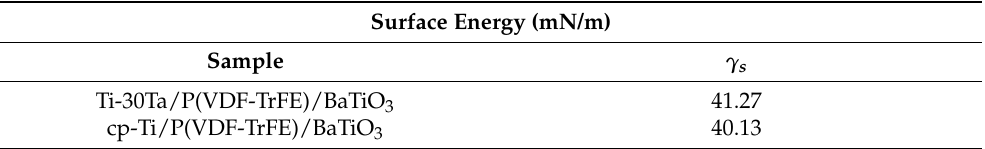
Table 8. Surface energy of the coated cp-Ti and Ti-3-Ta samples.